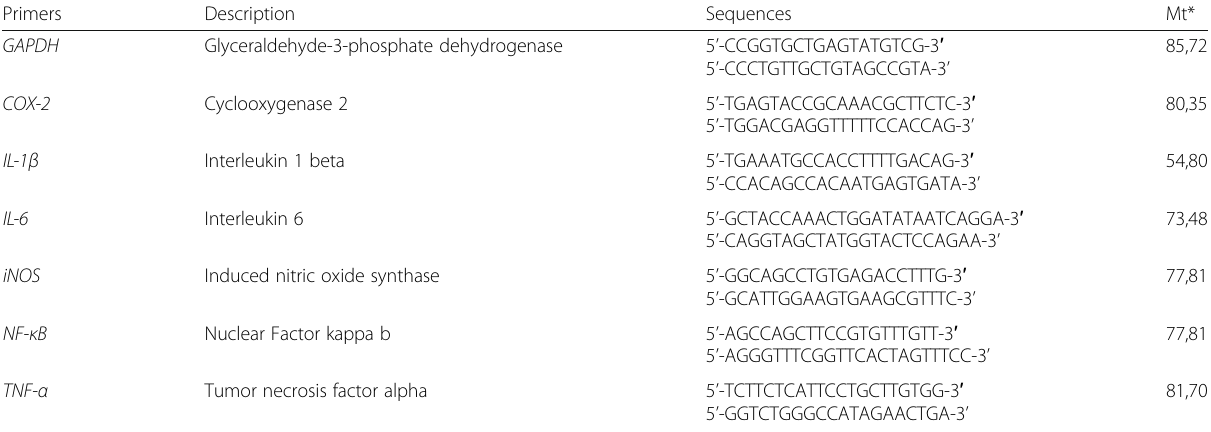
Table 1 RAW 264.7 macrophages genes analyzed in the study. Primers Description Sequences